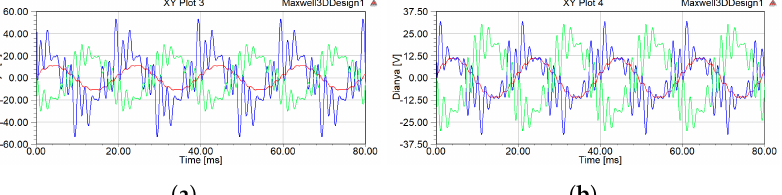
Figure 11. Voltage waveforms from the three windings under working condition 2. ( a ) The left column. ( b ) The right column.